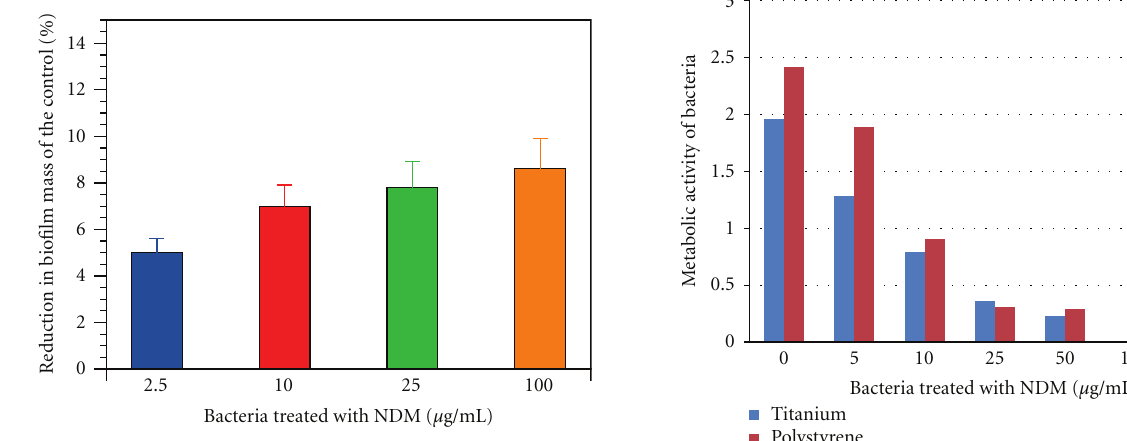
Figure 2: E ff ect of NDM treatment of bacteria on the biofilm mass as determined by crystal violet staining.